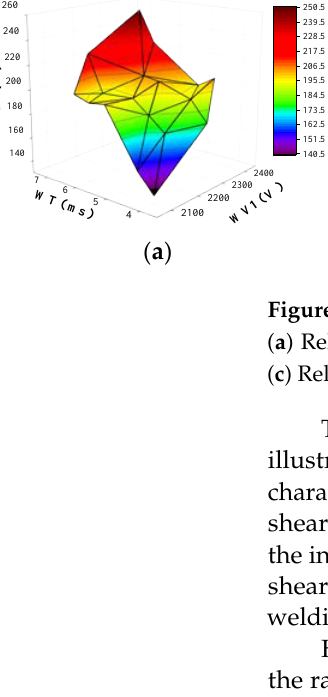
2.34 From Table 5 and Figure 7, the average relative errors of the positive electrode nugget diameter, negative electrode nugget diameter, and tensile shear load obtained by the CGO–MLSSVR prediction model are 1.72%, 3.51%, and 2.34%, respectively. This indicates